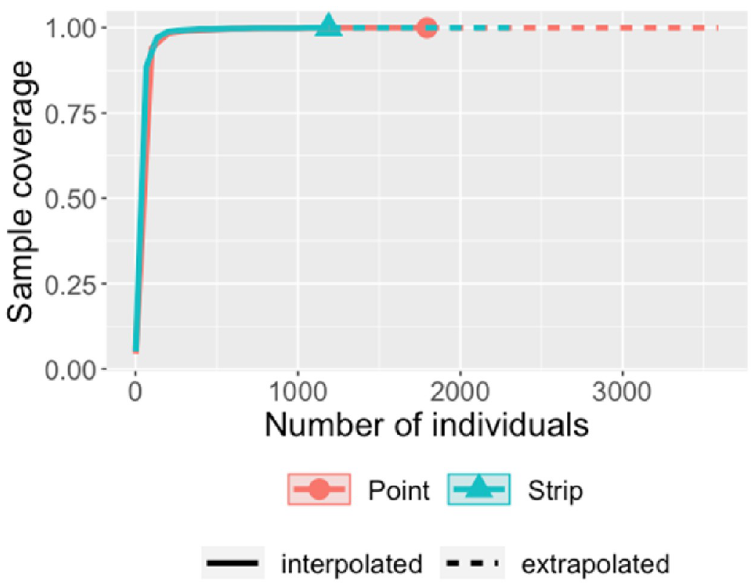
Fig 4. Sample coverage concerning the number of individuals of l raptors in winter seasons using roadside point count and strip transect methods in the arid region of Rajasthan.